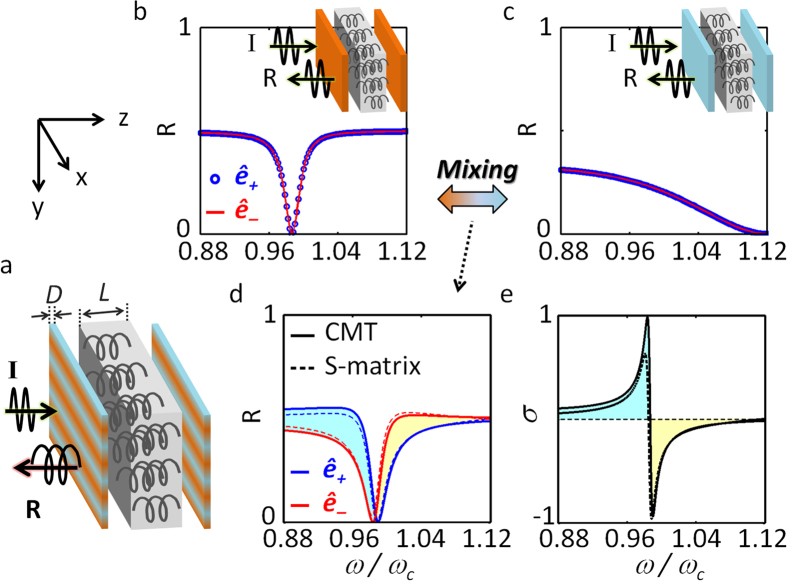
Spectral separation of optical SAM based on antisymmetric Fano resonances.(a) Proposed chiral resonator for SAM separation. A layer of a chiral medium (L = 0.29λc where λc = 2πc/ωc and ωc is the normalization frequency, εchiral = 9, χ = 0.05) is enclosed by a pair of birefringent mirrors (εx = εmetal = −80, εy = εdielec = 2.25, D = λc/60). Reflection spectra of ê+ (blue) and ê− (red) spin modes with (b) metallic mirrors (εx = εy = εmetal), (c) dielectric mirrors (εx = εy = εdielec), and (d) highly-birefringent mirrors (εx = εmetal, εy = εdielec). (e) Spectra of SAM density σ (±1 denotes pure ê±) with birefringent mirrors. The calculations are based on both CMT (solid) and a scattering matrix (dashed). The CMT fitting values for the resonance (ωx = 0.987ωc and ωy = 0.571ωc) and Q-factors (Qx = 100 and Qy = 12) for each mode (Fig. 2b,c) were obtained from the scattering matrix results.